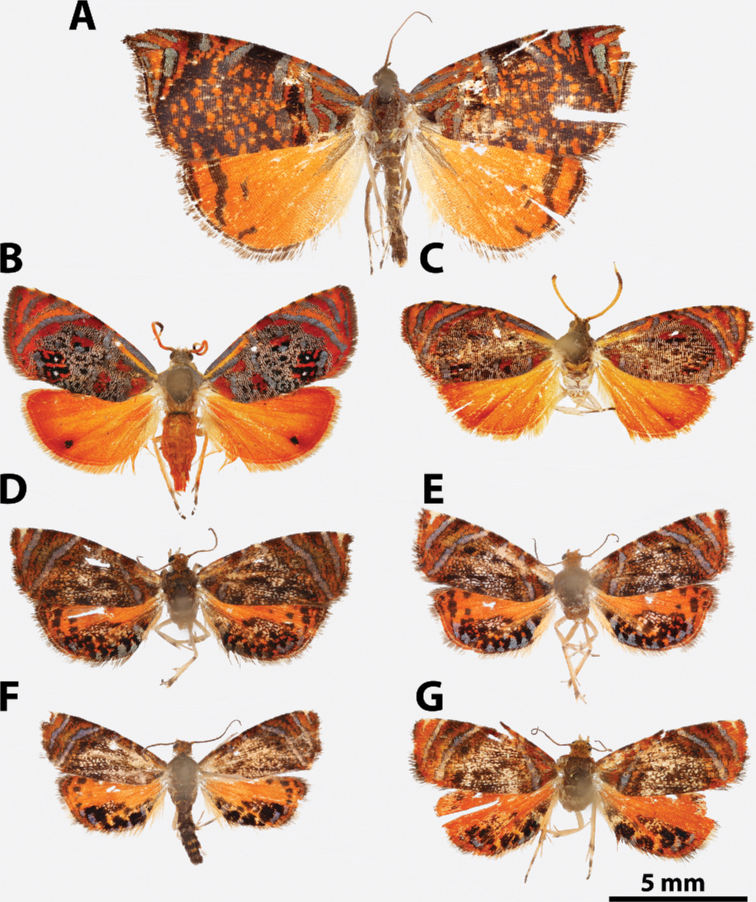
Mictopsichia group of genera. ARubropsichia
santaremana, ♂, Grenada (BMNH) BMictocommosis
lesleyae sp. nov. paratype, ♀, Dominican Republic (CUIC) CMictocommosis
lesleyae sp. nov. holotype ♂, Dominican Republic (CMNH). DMictopsichia
cubae ♂, Dominican Republic (CMNH) EMictopsichia
cubae ♀, Dominican Republic (CMNH) FMictopsichia
nyhllinda sp. nov. holotype ♂, Dominican Republic GMictopsichia
nyhllinda sp. nov. paratype ♀ Dominican Republic (CMNH).